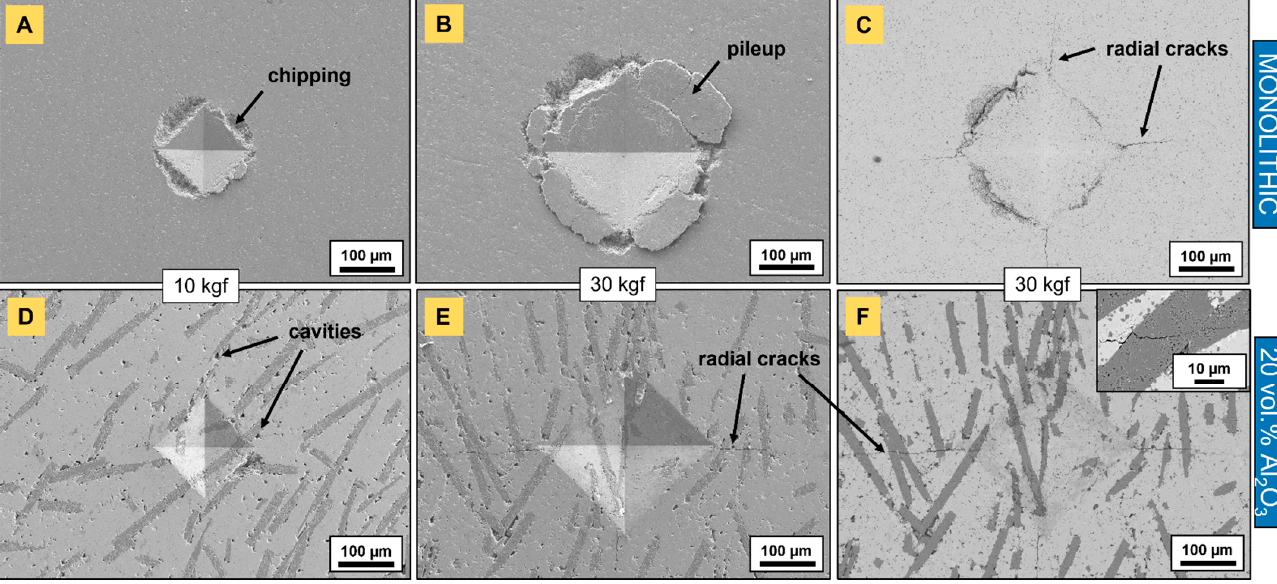
Figure 12. Vickers indentations on powder-bed-sintered monolithic and aluminosilicate fiber-reinforced (20 vol.%) Ti 2 AlC composites. ( A – E ) are SE images, and ( C , F ) are BSE images.